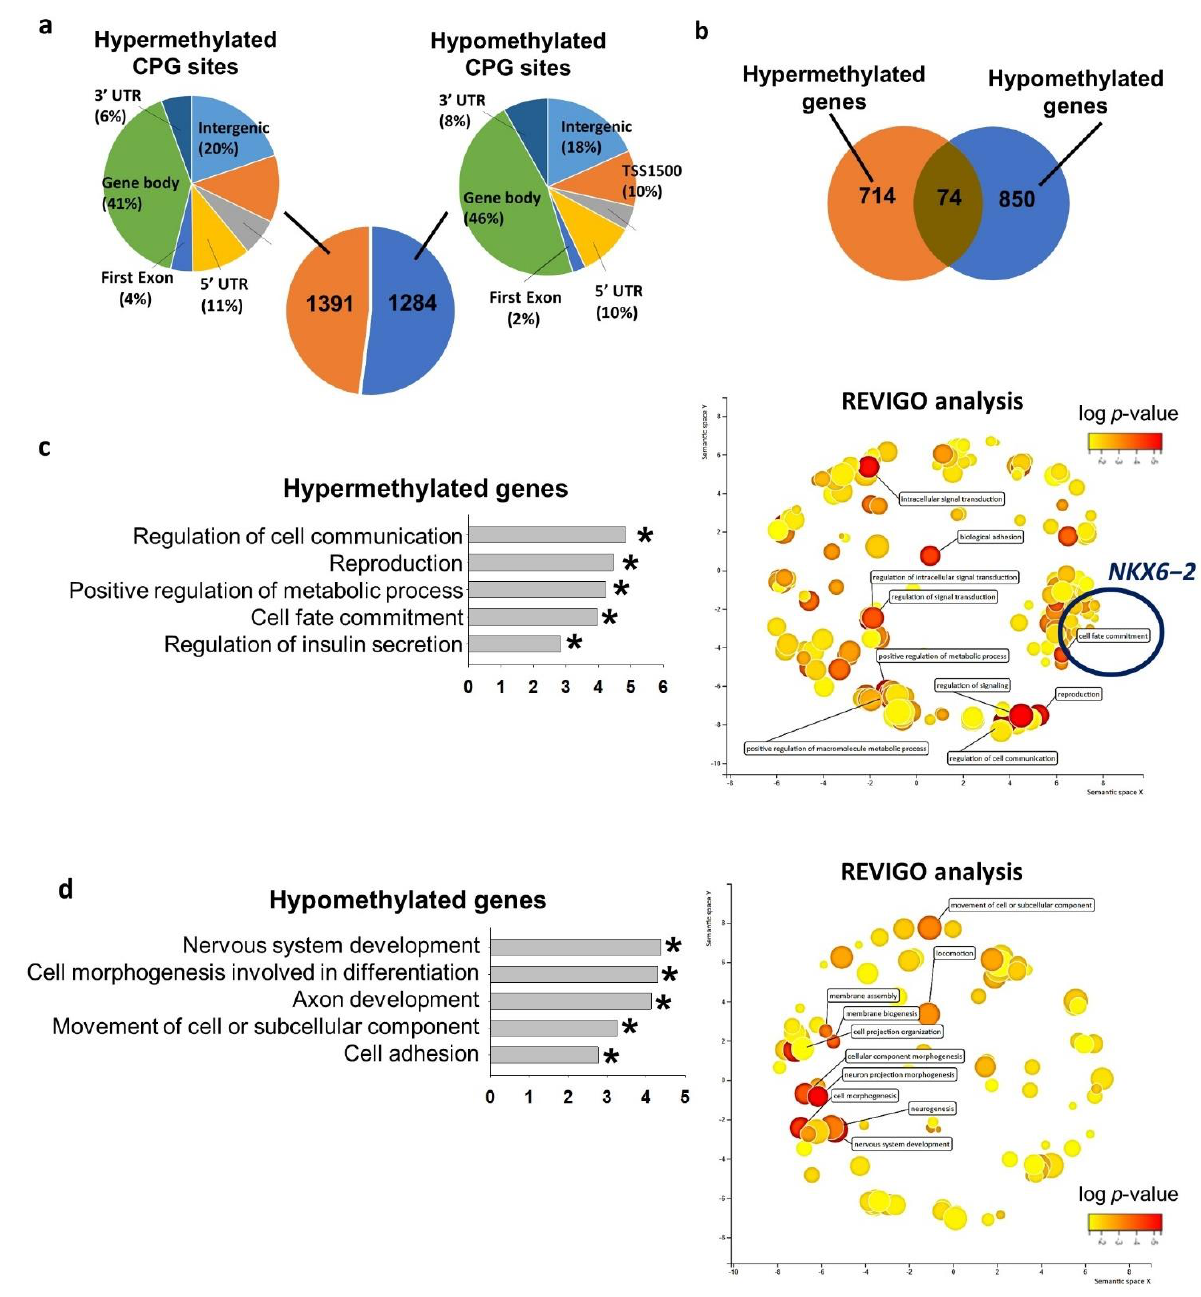
Figure 2. Hyperglycemia altered global DNA methylome in hESC. ( a ) Number of differentially methylated CpG sites in VAL3 under hyperglycemic condition (50 mM d-glucose; 13.7 mM basal level as control) and their genomic distribution. UTR: untranscribed region, TSS1500: 1500 bp upstream of transcription start site, TSS200: 200 bp upstream of transcription start site. ( b ) Number of differentially methylated genes in VAL3 under hyperglycemic condition. ( c ) ( left ) Gene ontology analysis of the hypermethylated genes. (* p < 0.05), ( right ) Cluster-plot of gene ontology terms processed with REVIGO analysis. Top 10 grouped gene ontology terms were shown. ( d ) ( left ) Gene ontology analysis of the hypomethylated genes. (* p < 0.05), ( right ) Cluster-plot of gene ontology terms processed with REVIGO analysis. Top 10 grouped gene ontology terms were